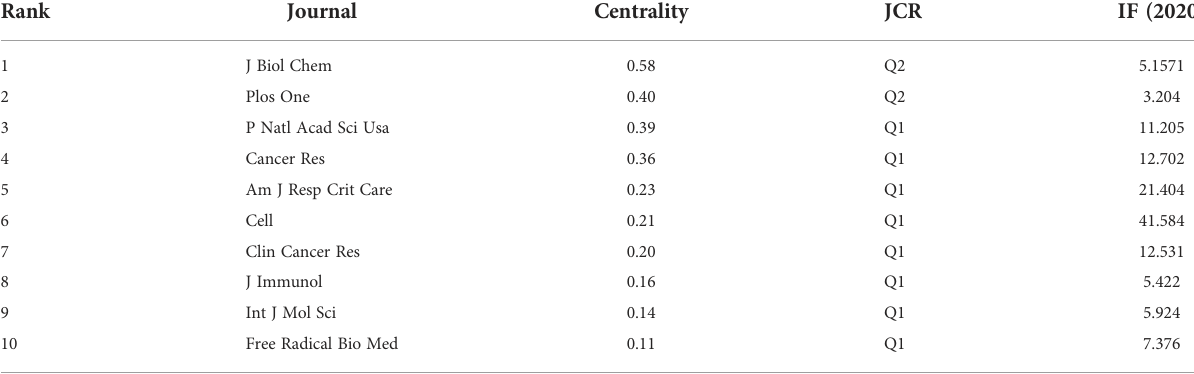
TABLE 5 Top 10 journals for centrality of autophagy research in lung disease. Rank Journal